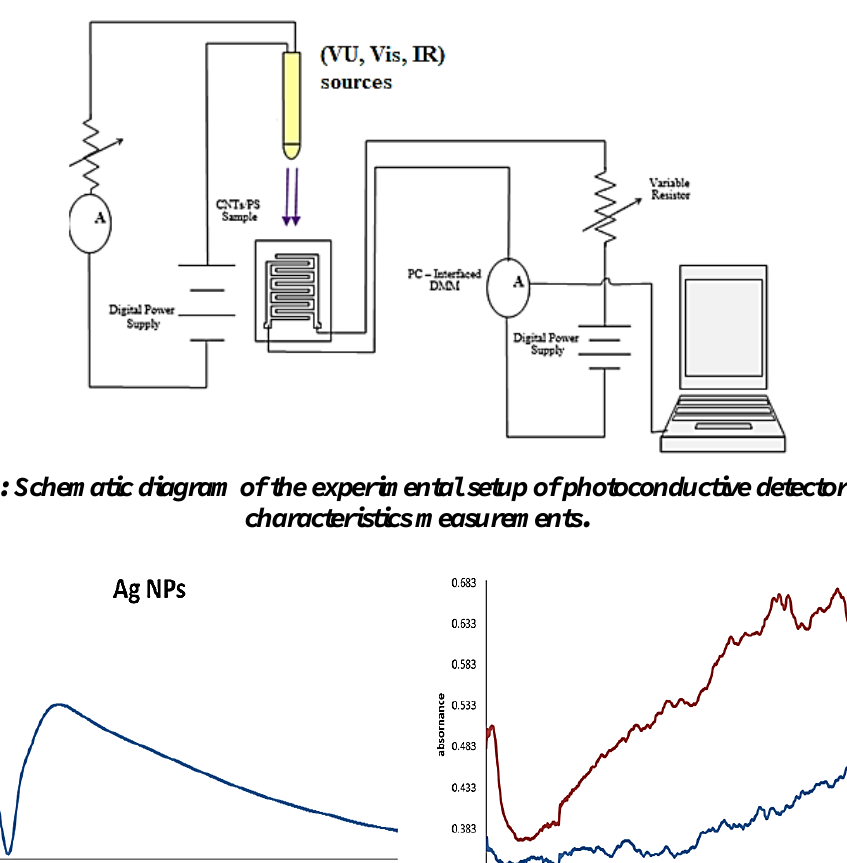
Figure 4: UV-Vis. absorption spectra of Ag nanoparticle.